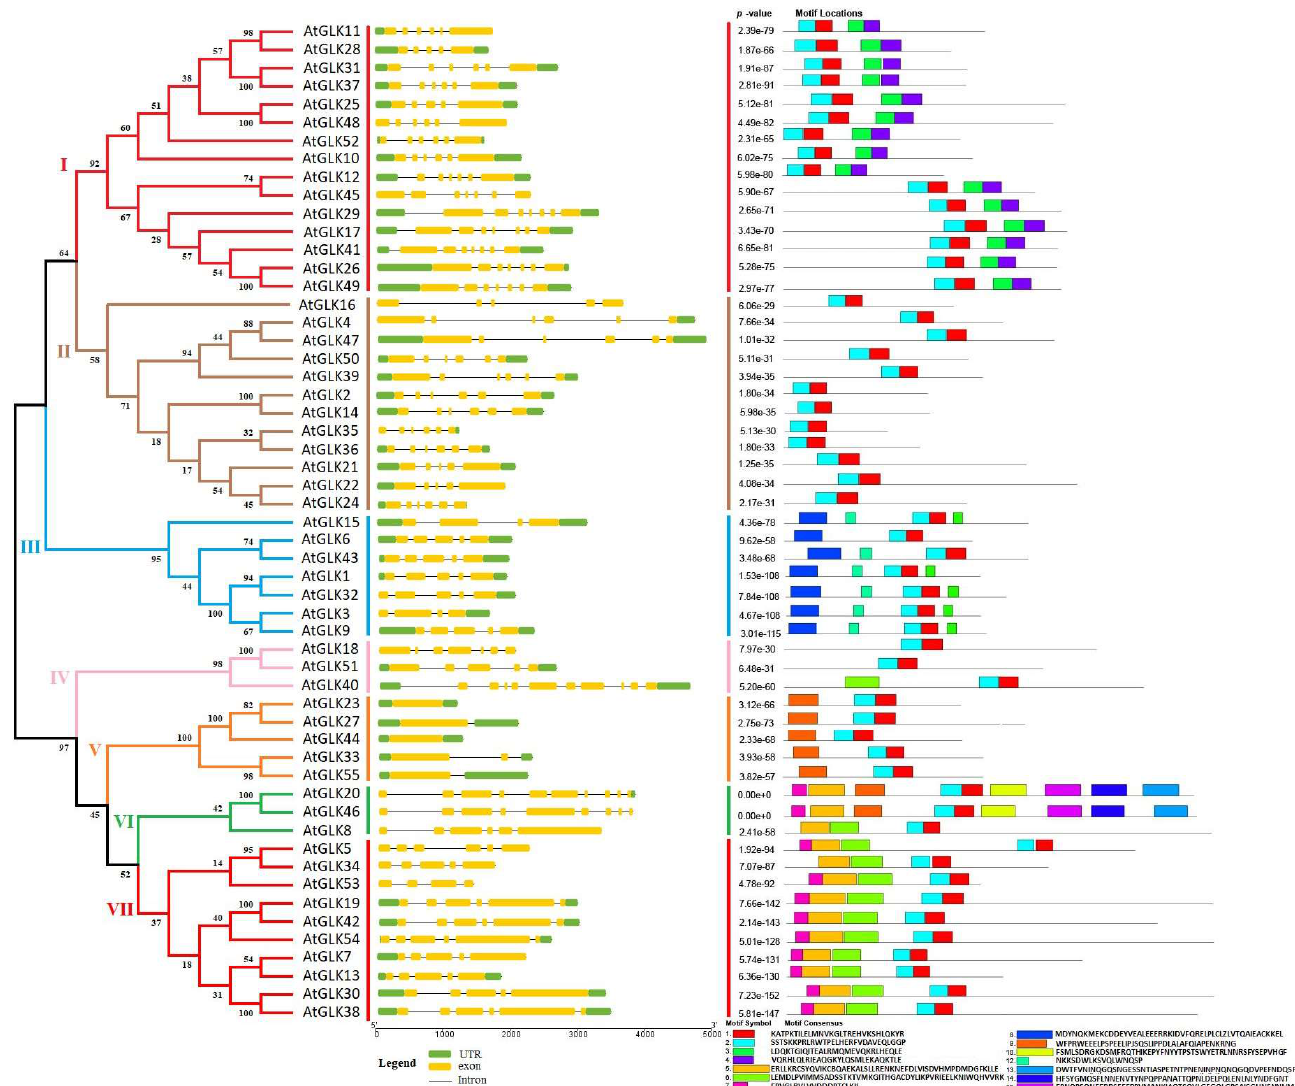
Figure 1. Schematic diagram of Arabidopsis GLK gene structural organization and motifs composition. On the left, the Maximum Likelihood method (M.L) evolutionary tree, followed by the gene structure with exons-introns, shown as yellow color boxes and black lines. The left side of the picture is followed by the conserved motifs presented in various colors. Black lines indicate Non-conserved sequences.